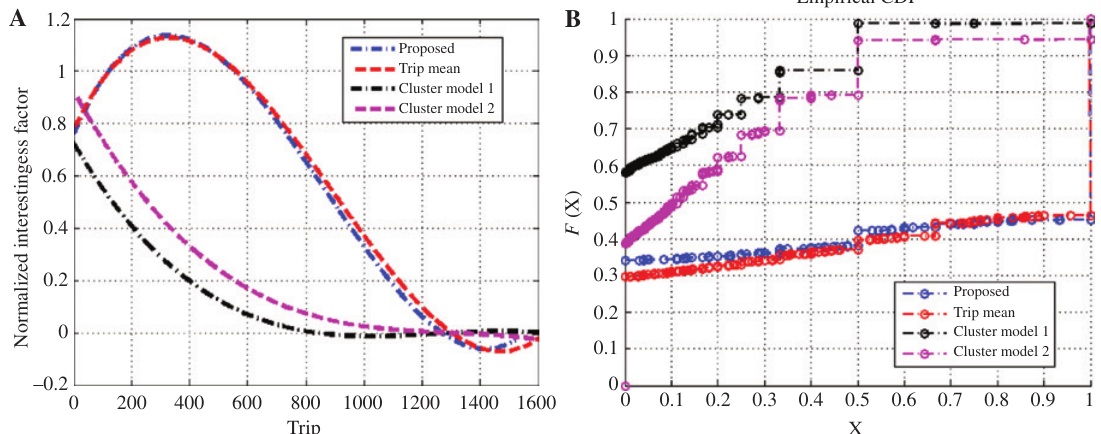
Figure 7: Performance Comparison Using (A) Normalized Interestingness Factor Over Every Trip Plan and (b) Its Distribution for 10% Tolerance.